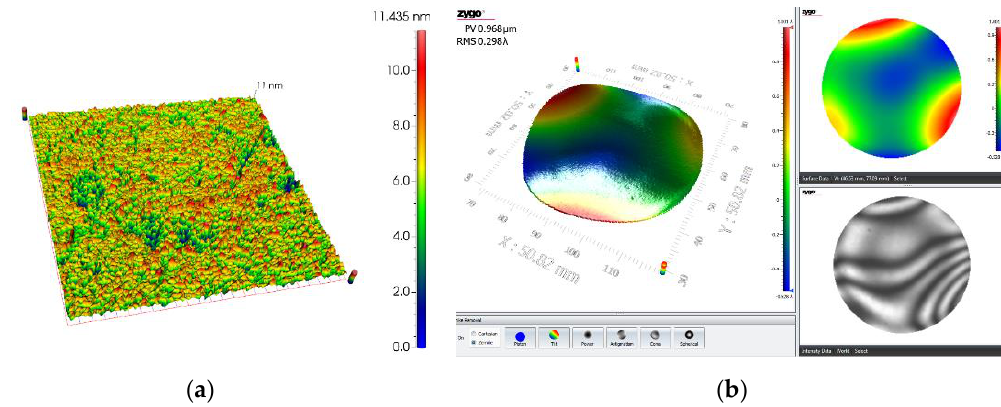
Figure 10. Surface morphology of sapphire based on LSC after double-sides polishing: ( a ) surface roughness measured by white light interferometer, the roughness ( R a ) is 1.4 nm and the 3D surface roughness ( S a ) is 1.1 nm; ( b ) the flatness of ultra-thin sapphire (PV) is 0.968 μm.